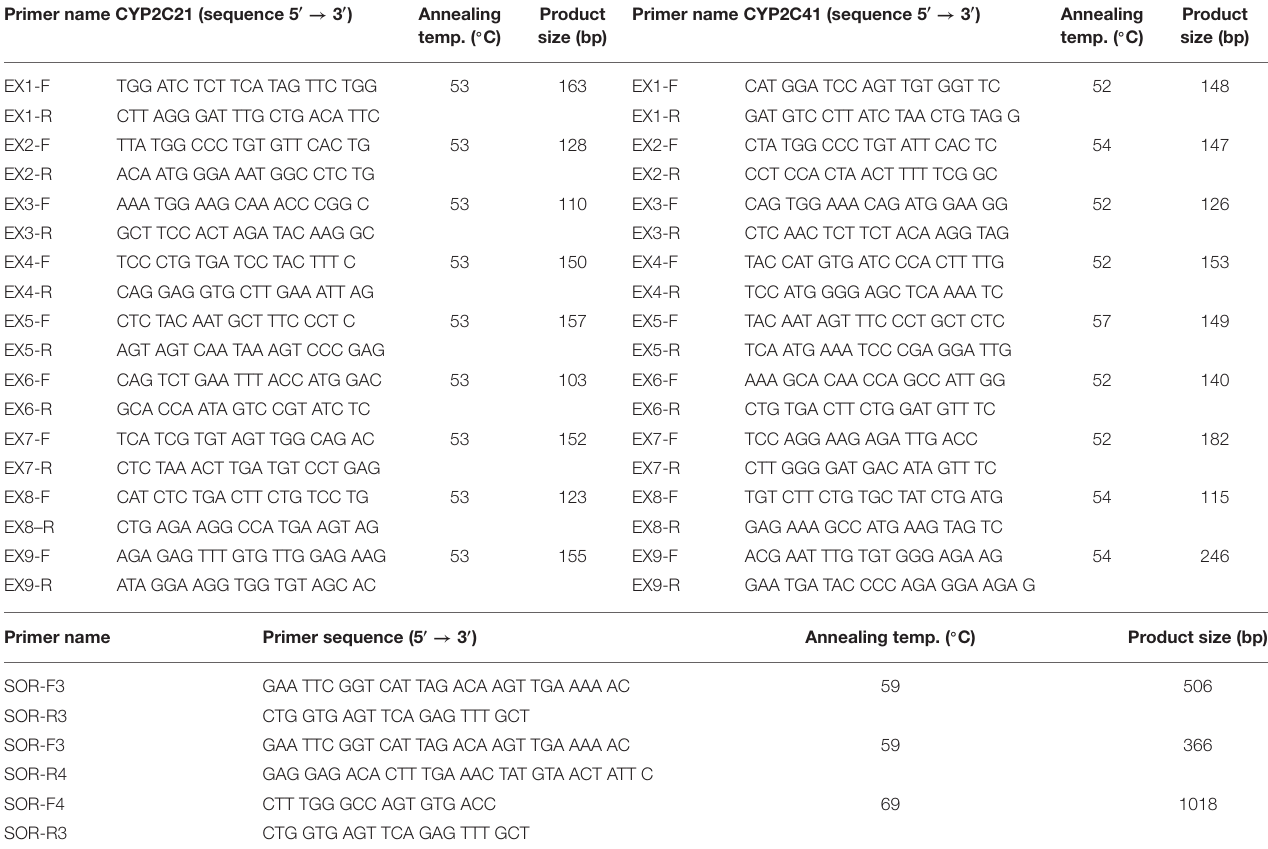
TABLE 1 | Primers used for